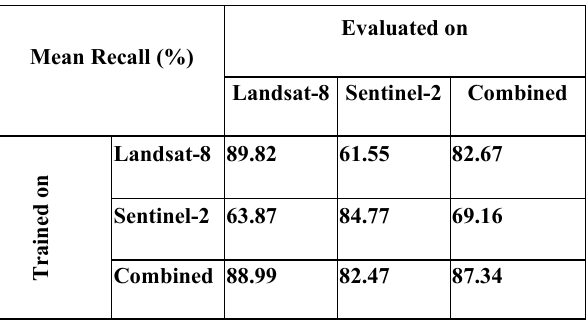
Table 5: Mean recall values on different types of datasets.